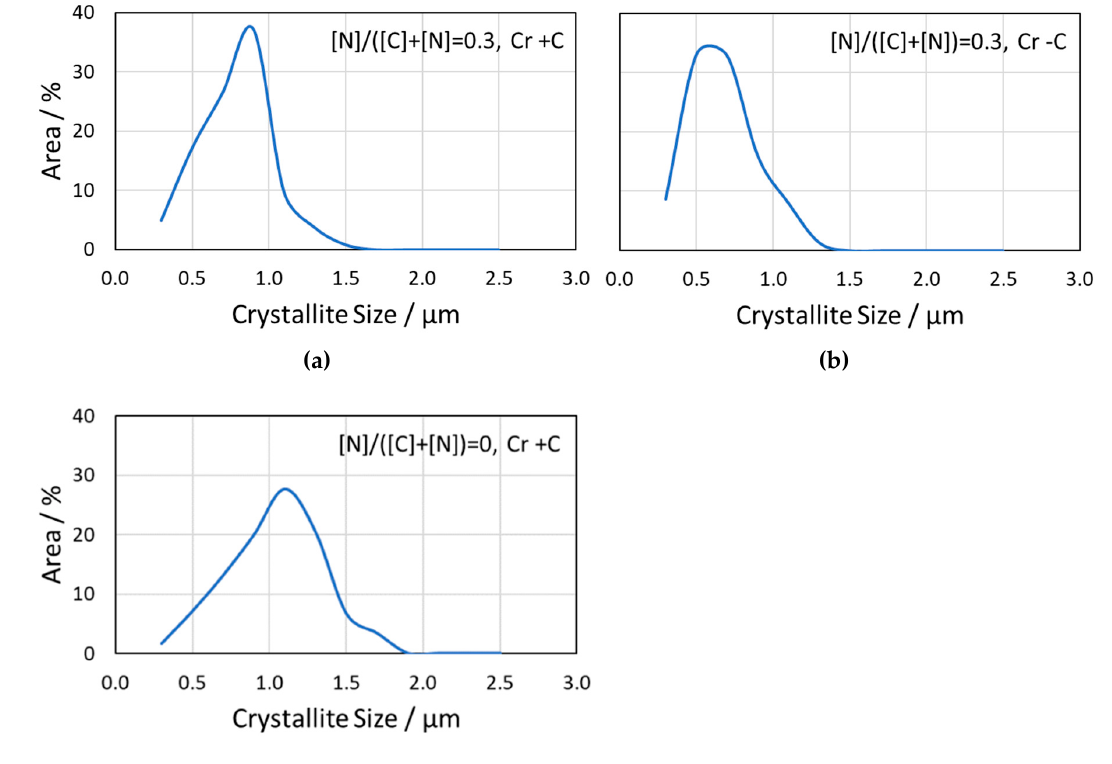
Figure 7. Crystallite-size distribution of the MC / M(C,N) phase in Cr-doped samples, ( a ) high C activity (“ + C”, Ms ≈ 88%) and ( b ) low C activity (“ − C”, Ms ≈ 75%) at ([N] / ([C] + [N] = 0.3 of added TiC / TiN phase. ( c ) no nitrogen content, [N] / ([C] + [N]) = 0, of the MC / M(C,N) phase at high C activity (“ + C”) of the hardmetal (Ms ≈ 88%), C activity as ( a ).